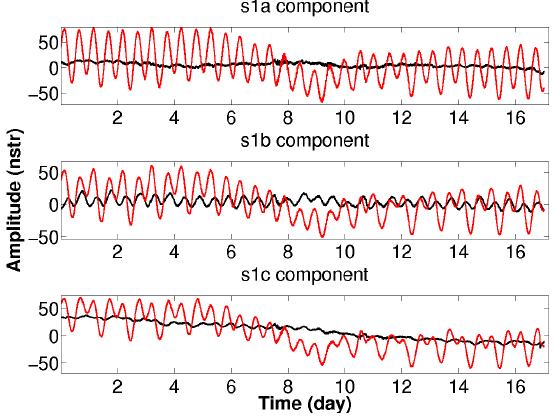
Figure 10. 17daysofstrainrecordsatMOK,june2010: (redcurves) detrended record of strain signal on each component; (black curves) residual strain signal obtained by the dif- ference between the observation and the prediction (see figure 9). The s1b component exhibits a significant 12h- period residual, interpreted as resulting from a pore pres- sure diffusion from the nearby sea.